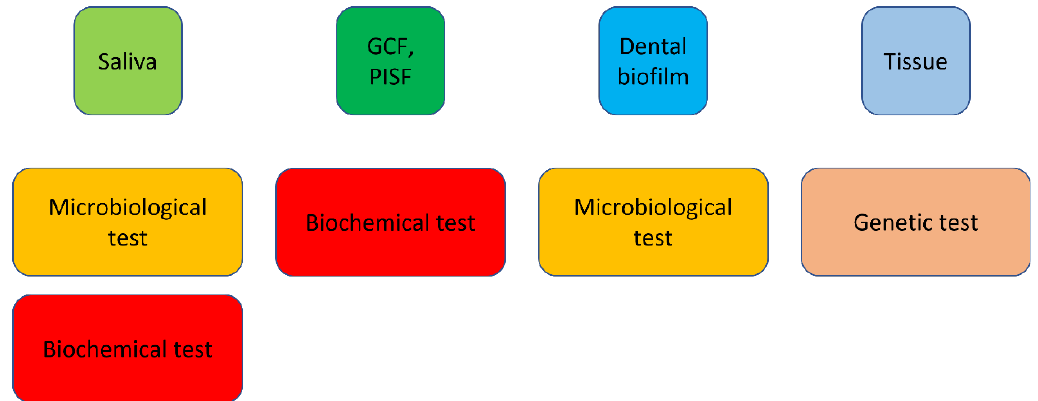
Figure 1 : Biological source of biomarkers in the oral cavity and the corresponding assays used for Point of Care